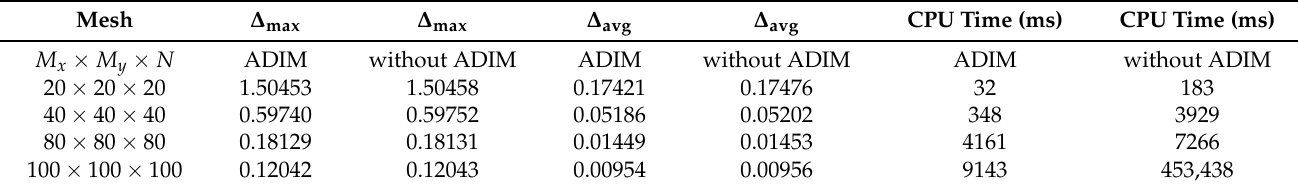
Table 1. Comparison of the results and the times of the algorithm computation depending on the use of ADIM.